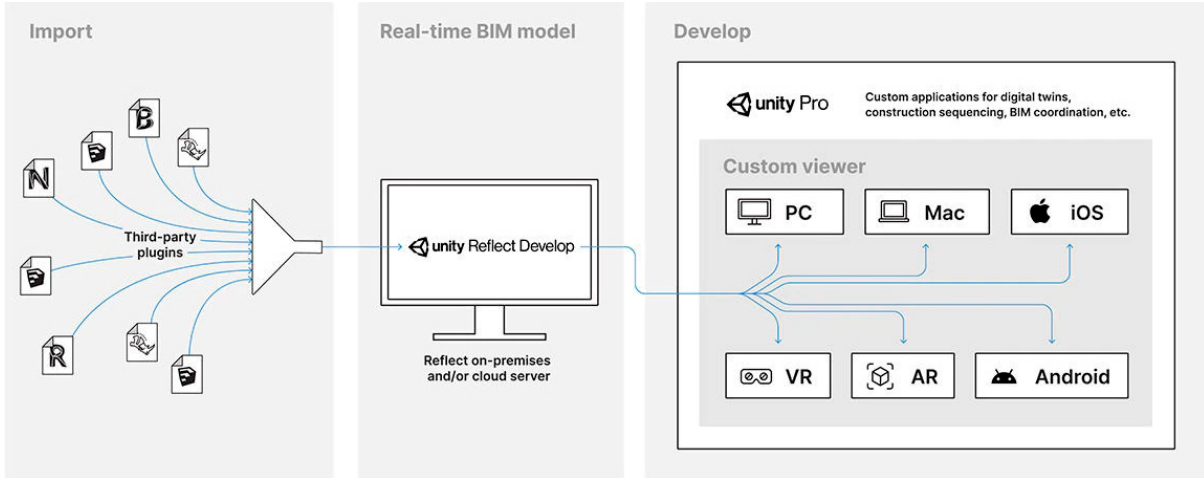
Figure 15. Unity Reflect interoperability from the producer’s instruction.